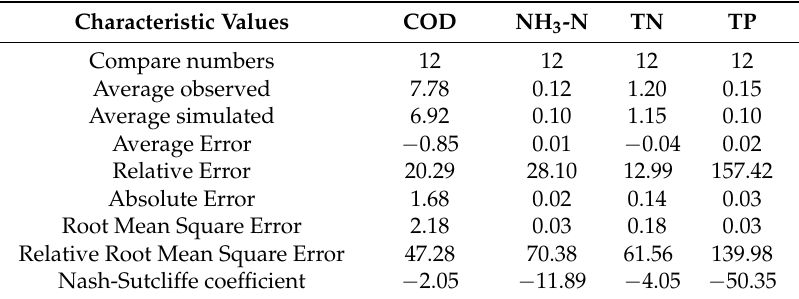
Table 6. The error statistics of the model verification (units: